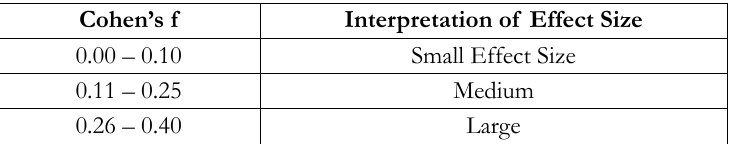
Table 3. Cohen’s f interpretation (Cohen,